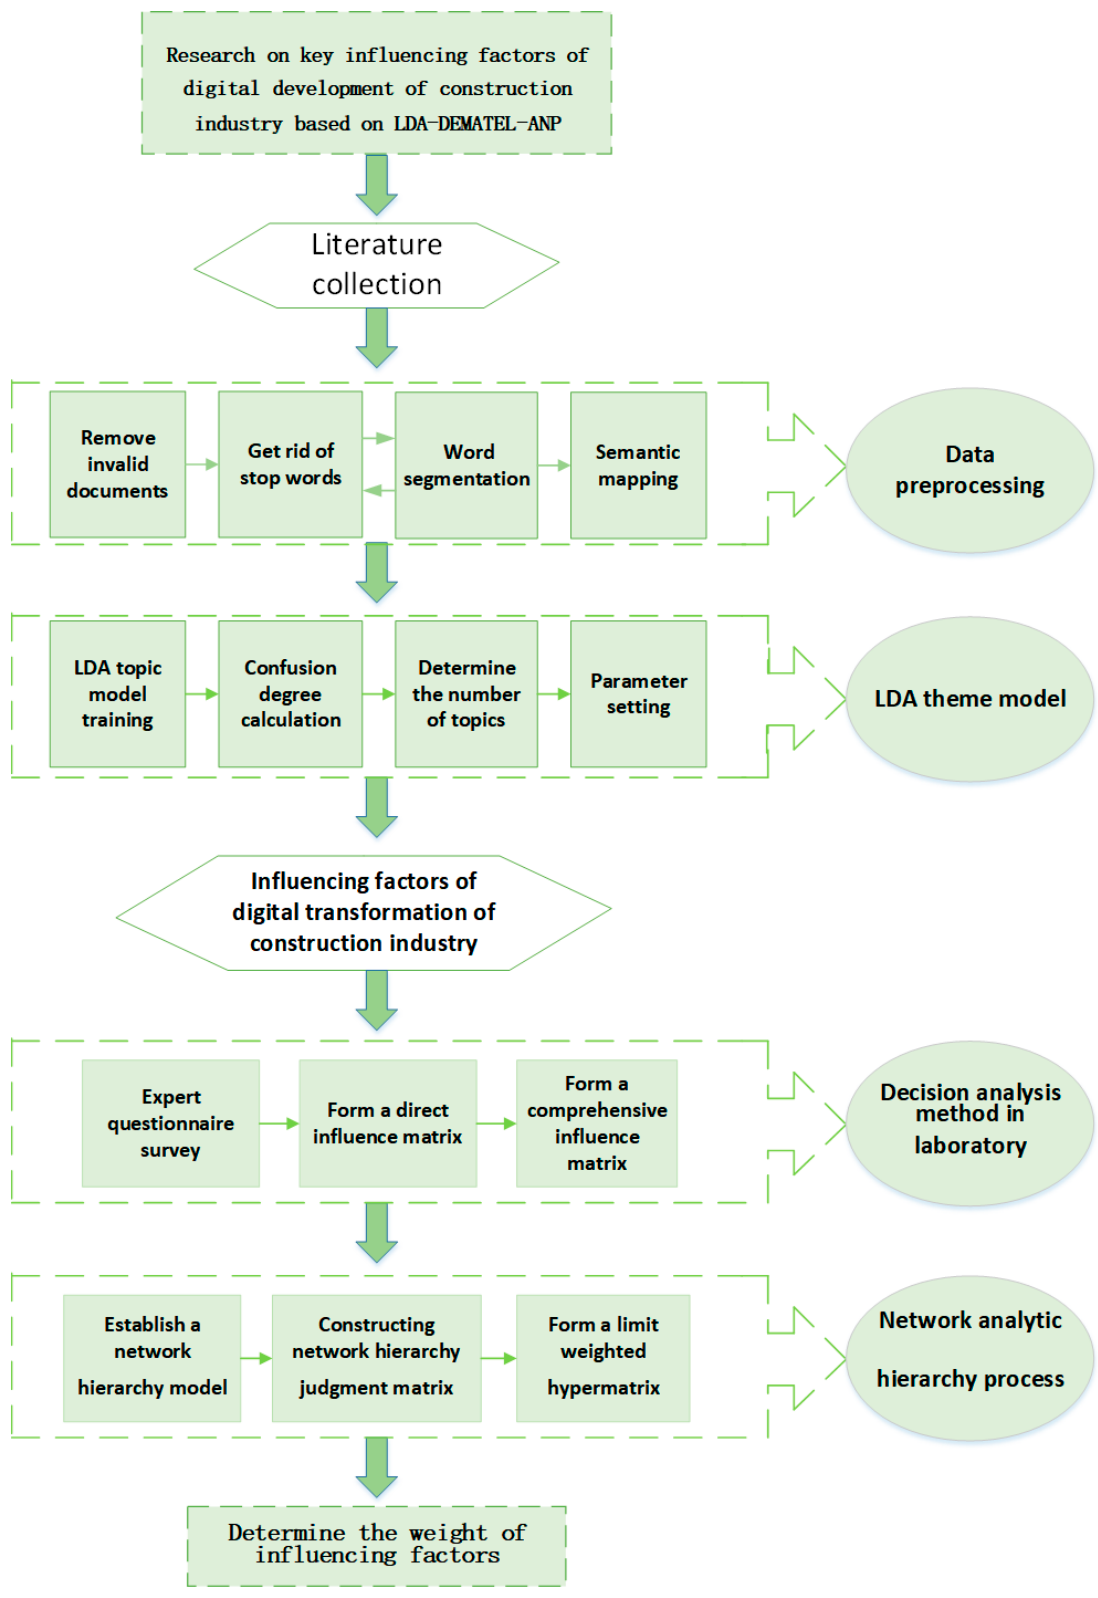
Figure 1. The research framework.